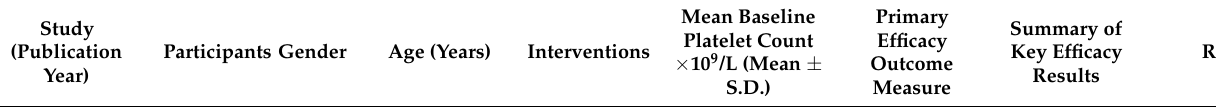
Table 1. Summary of Phase 3 Clinical Trial Efficacy Results of Avatrombopag and Lusutrombopag for the Treatment of TCP in Patients with CLD Undergoing Invasive